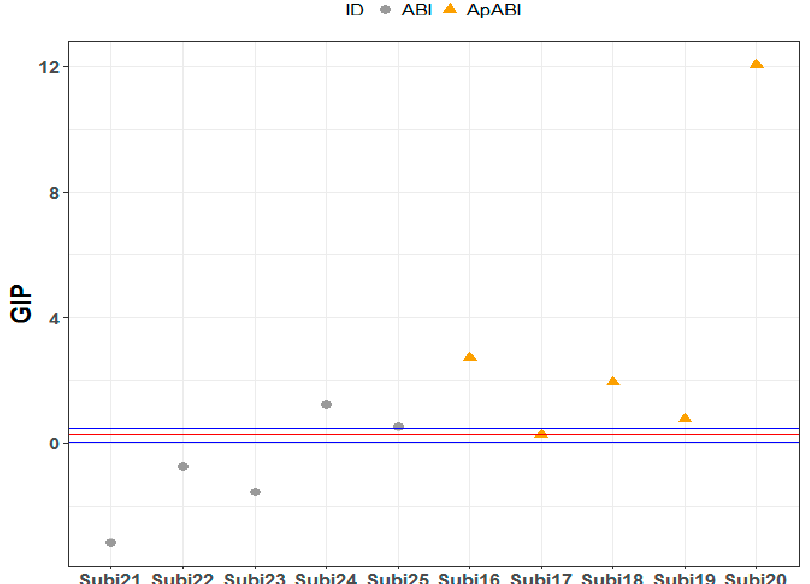
Figure 8. F-FT: GIP mean value of the difference between incongruent and congruent stimuli of each ABI patient, distributed above, below, or within the 95% confidence interval of control group. Red line = GIP mean value of the difference between incongruent and congruent stimuli of the control group; blue line = confidence limits, the two extreme values of the confidence interval which define the range.